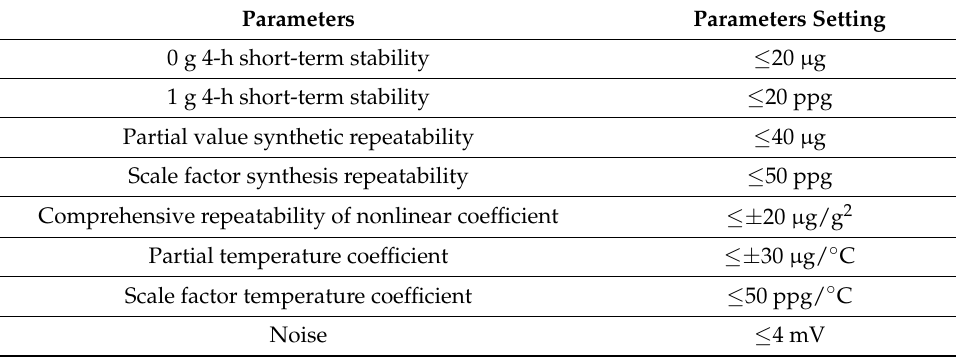
Figure 5. Physical graph of quartz flexible accelerometer. Table 1. Parameter list of quartz flexible accelerometer.